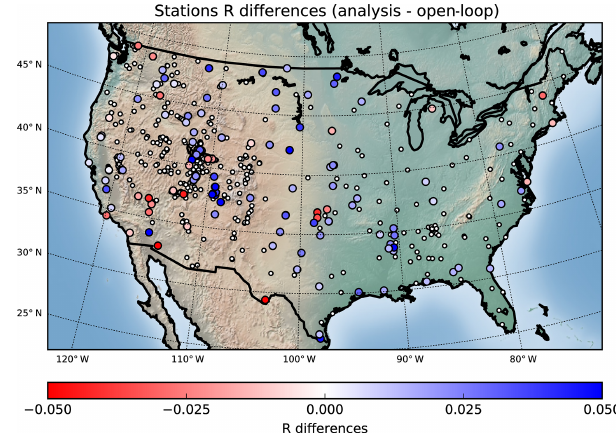
Figure 9. Map of correlation ( R ) differences (analysis minus open- loop) for stations measuring soil moisture at 5cm depth and being available over North America. Small dots represent stations where R differences are not significant (i.e. 95% confidence intervals are overlapping), large circles where differences are significant.